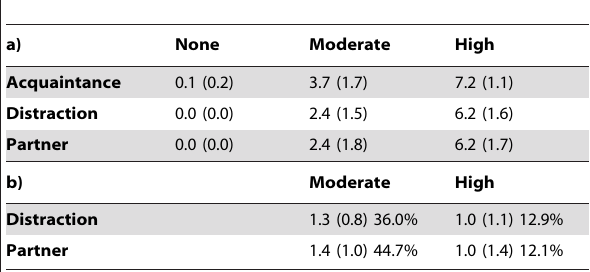
Table 1. Pain ratings by temperature and task.